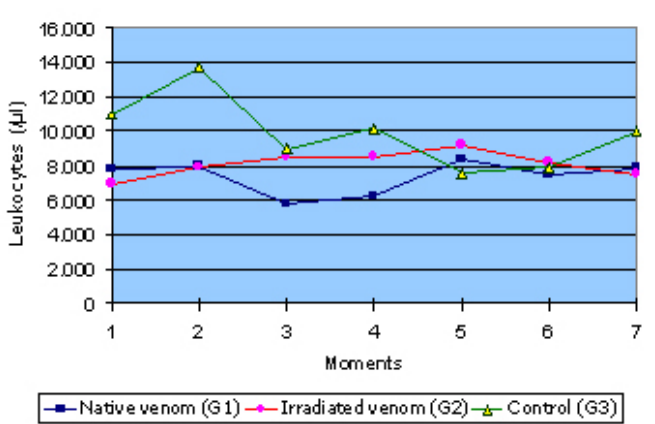
Figure 4: Mean values of total segmented neutrophils count (/µl) in ovine groups inoculated with natural (G1) and 60 Co-irradiated (G2) C.d.t. venom, and control group (G3), at different moments.